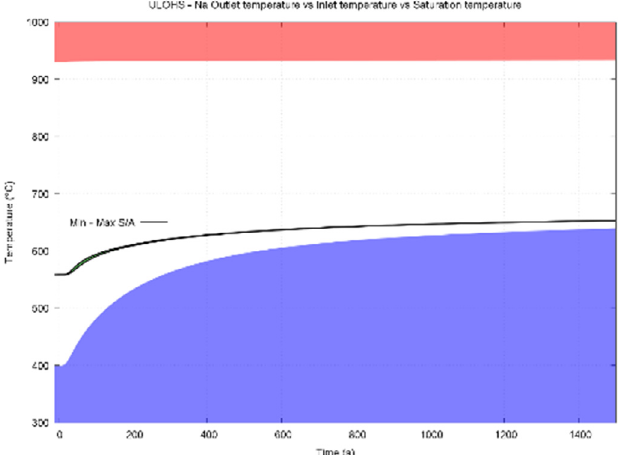
Fig. 12. Core temperature.